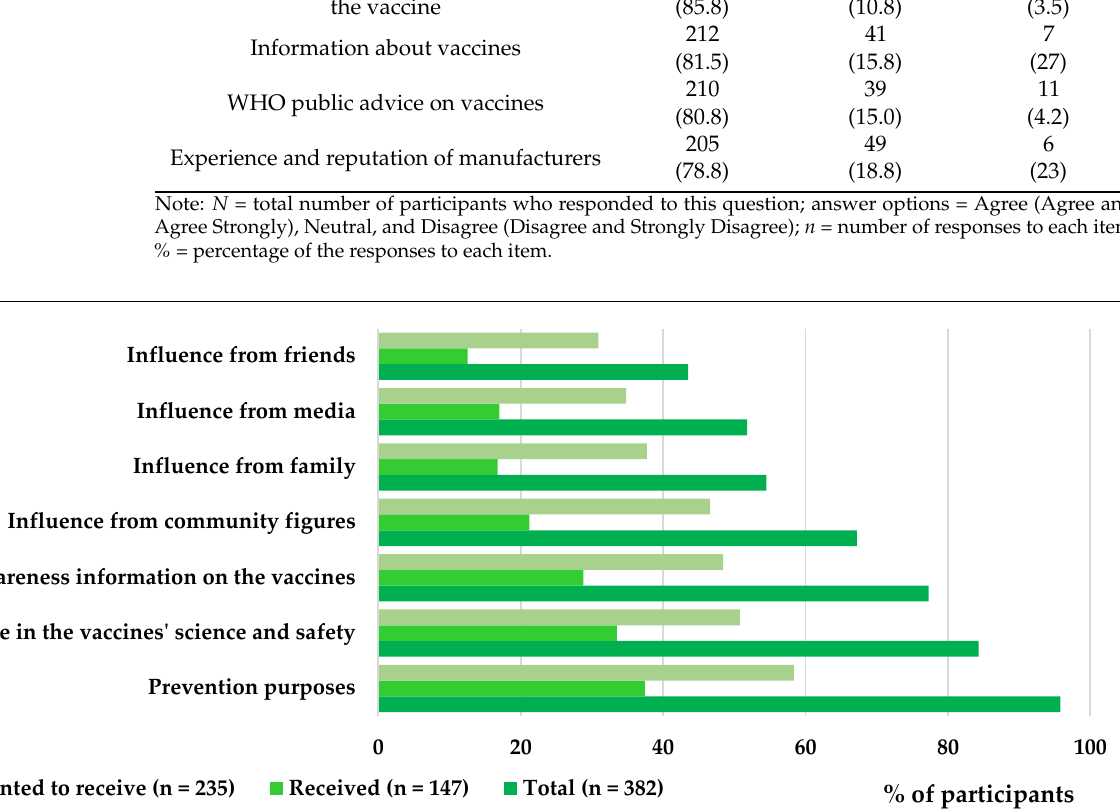
Figure 5. Factors that drive the refusal of COVID-19 vaccines.